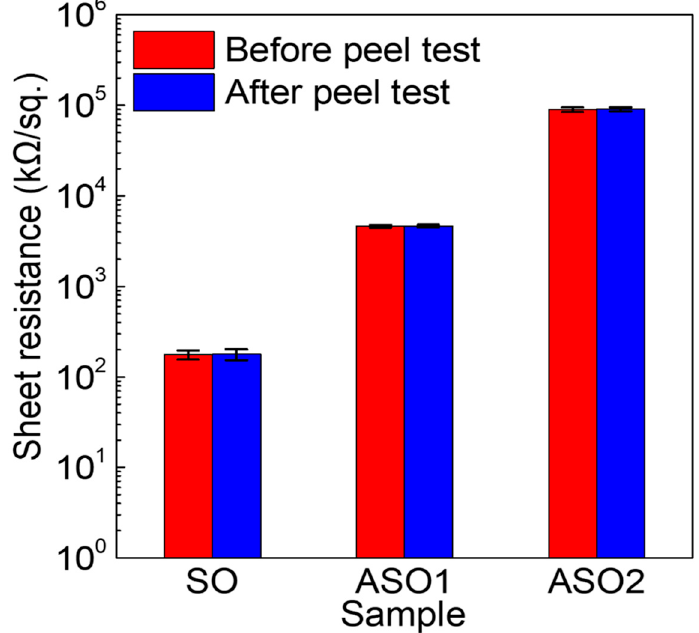
Figure 6. Sheet resistance changes before and after the peel test for SO, ASO1, and ASO2 thin films on a polyimide (PI) substrate.